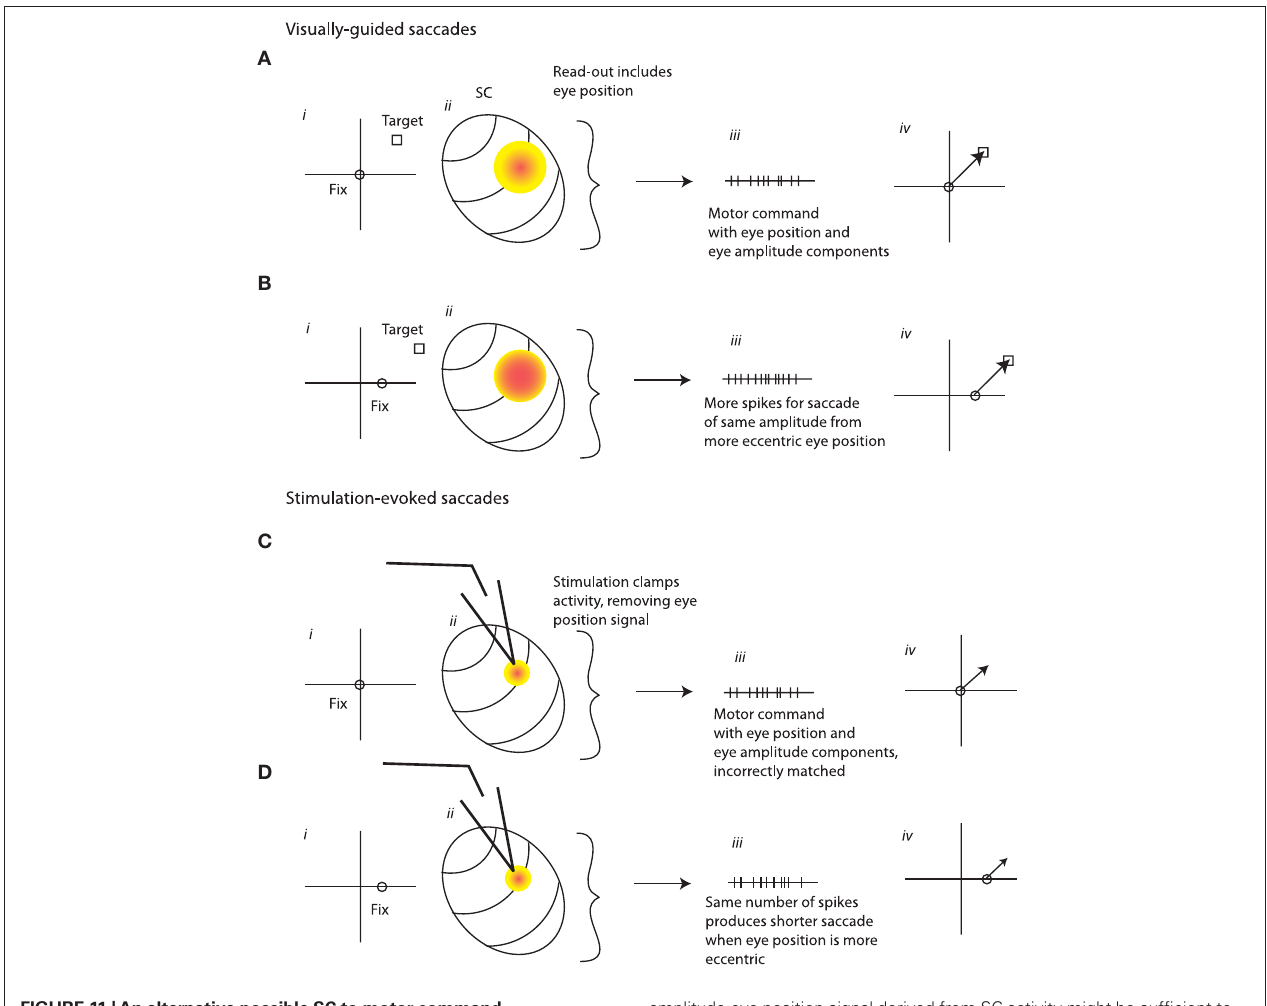
FIgure 11 | An alternative possible SC to motor command transformation. (A,B) As in Figure 10 , the level of activity in the SC normally varies with eye position (ii) , but here this variation is reflected in the computation of the SC’s output signal (iii) . Another difference is that the eye position signal in the SC is positively, rather than negatively, correlated with the movement field/site of activation, so that the number of spikes in the output is higher for more contralateral fixation positions. The combined eye